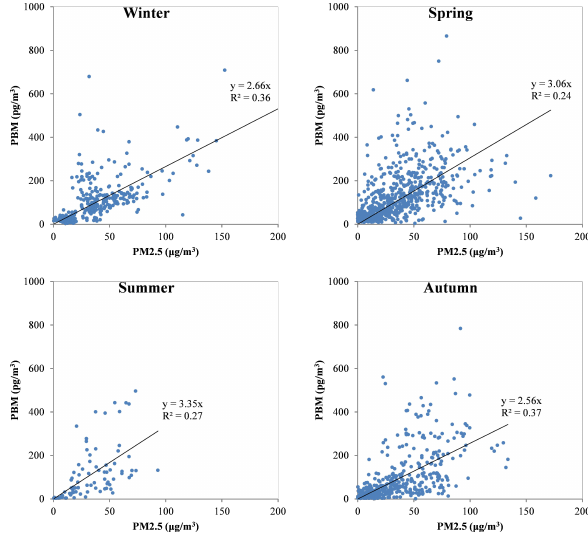
Fig. 9. Relationship between PM 2 . 5 and PBM in different